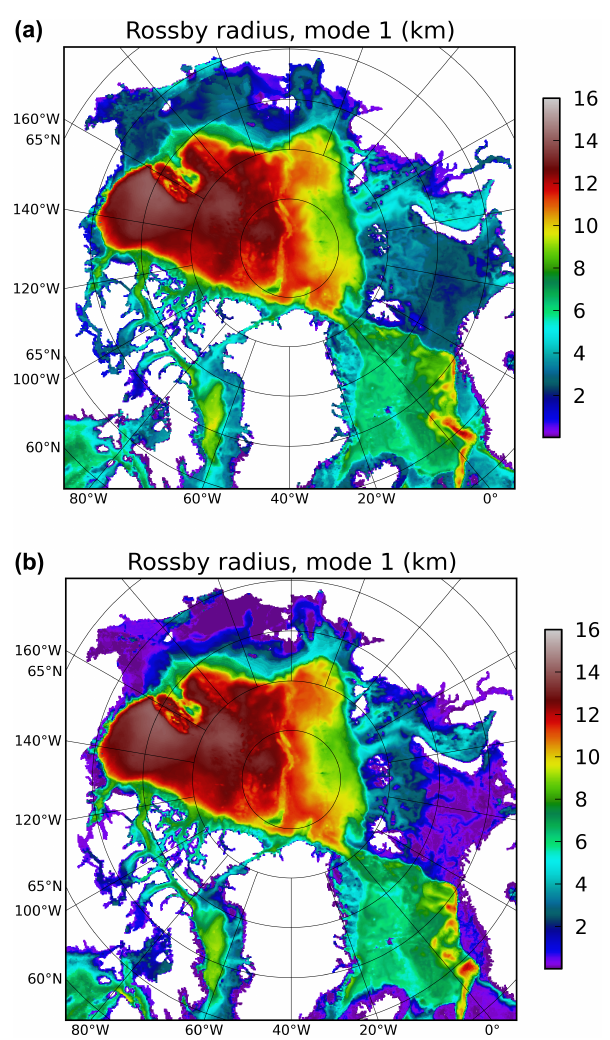
Figure 6. (a) OCCAM Rossby radius mode 1 (km) for August 1992. (b) OCCAM Rossby radius mode 1 (km) for March